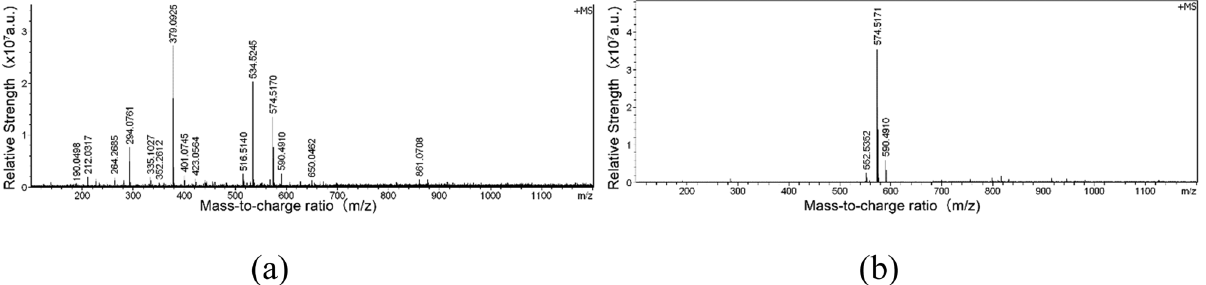
Figure 8: The mass spectrum of 17:0 ceramide by CCA ( a ) and TiO 2 ( b ) as the